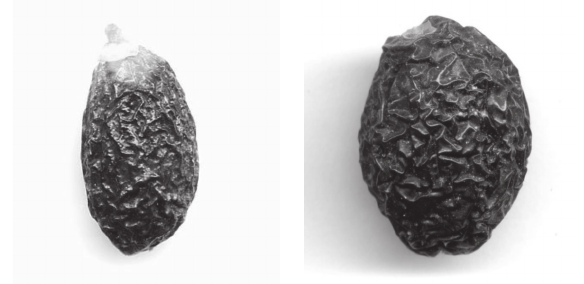
Figure 1. Olives harvested from orchards and showing symptoms of anthracnose.